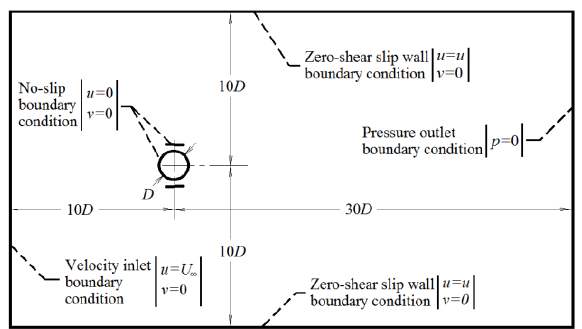
Fig. 2. Geometry of computational domain where length is in diameter of the cylinder ( D ) and boundary conditions. For the present computations, the inflow boundary condition is taken from the experimental results.